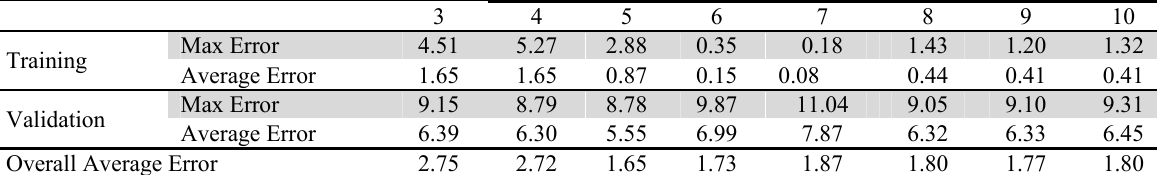
show the effect for varying the neurons for Trials 1, 2, and 3 respectively. Table 8 Maximum and average errors for Trial 1